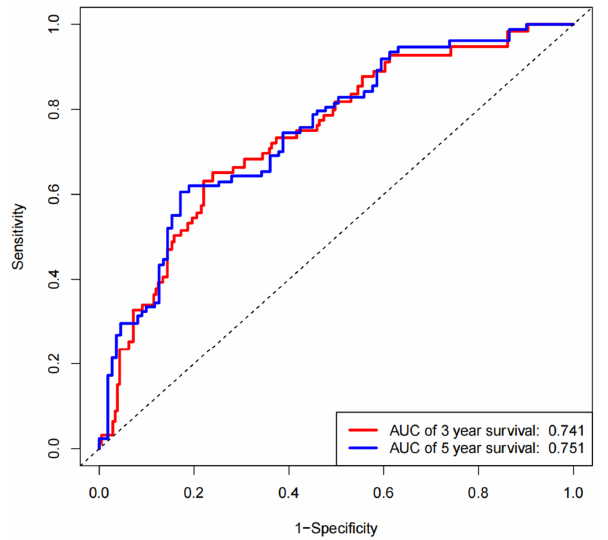
Figure 6. AUC of risk signature in ROC analysis was calculated for EC patients with 3- and 5-year survival time.